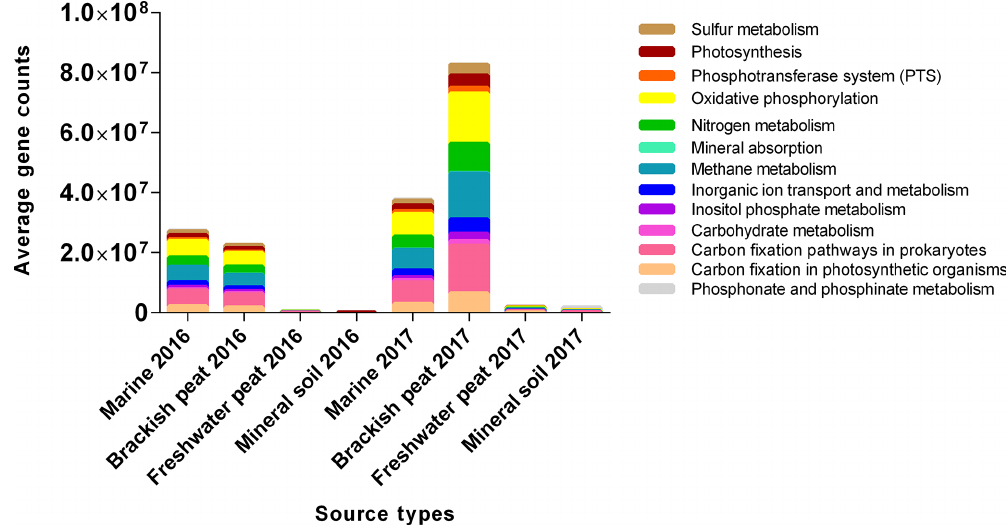
Figure 6. The relative abundance of predicted functional profiles in the four source types across two seasons based on KEGG